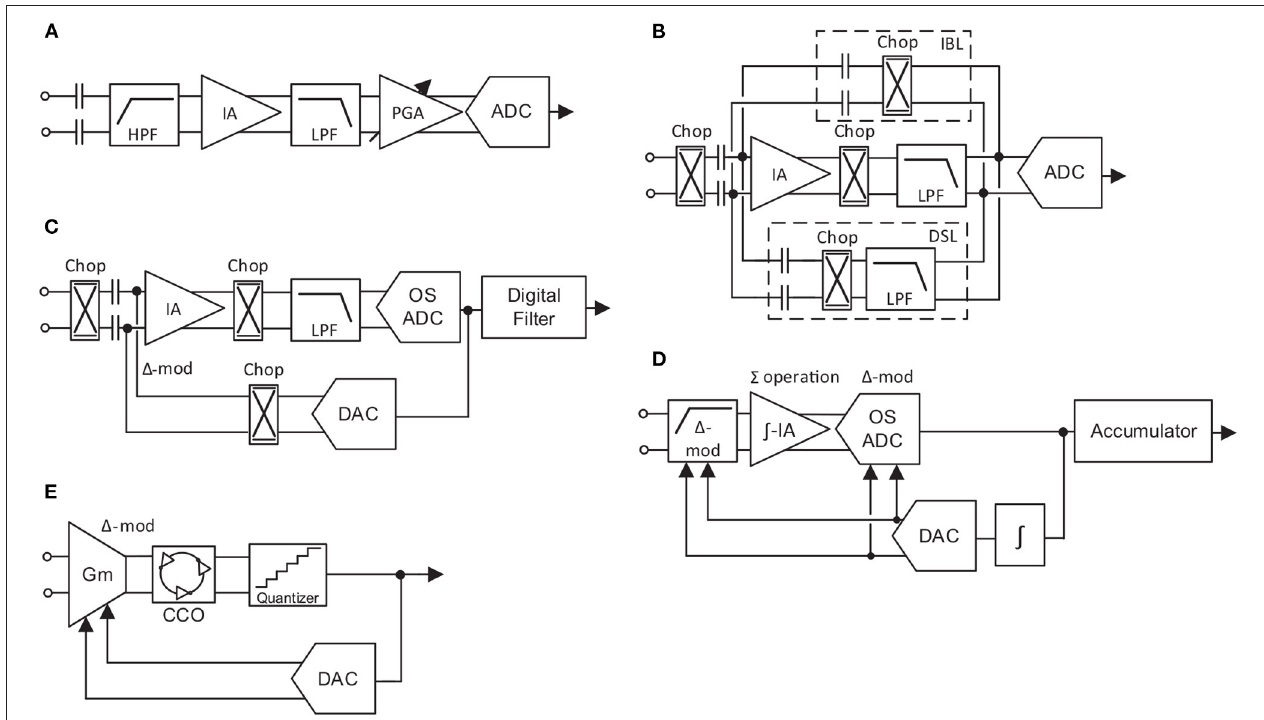
FIGURE 4 | Block diagram of high-performance neural AFEs. (A) Continuous-Time AFE topology. (B) Chopper-stabilized AFE topology. (C) Chopper-based 1 -AFE topology. (D) 1 2 6 AFE topology. (E) VCO-Based 61 AFE topology.